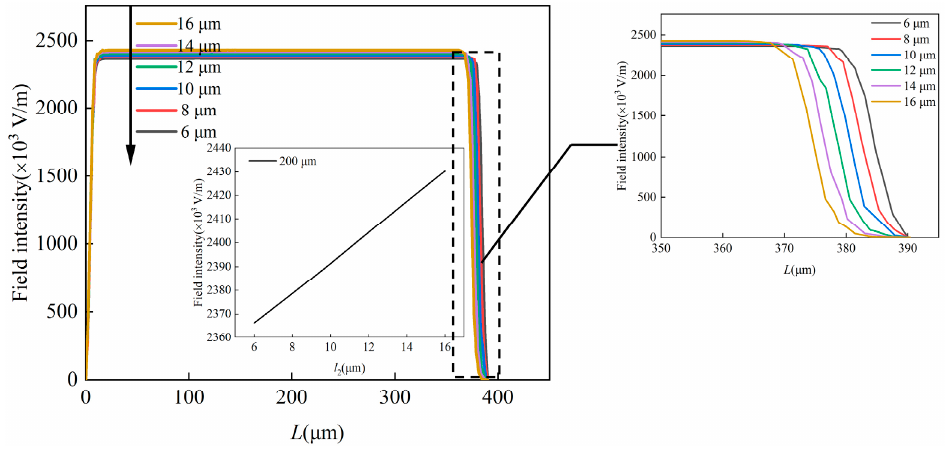
Figure 6. Effect of the penetration depth on the field intensity in the channel. The influence of output–electrode penetration depth on the secondary electron mul- tiplication at a DC mode were shown in Figure 7. The electrode at the output end of the microchannel plate is the anode and the electrode absorbs some electrons when the electrons move to the end, i.e., electrode end spoiling, which directly affects the electron